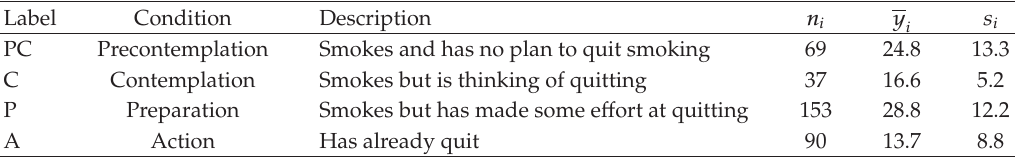
Table 4: Sample sizes, means, and sample standard deviations of 349 women who stopped smoking during pregnancy period (cid:5) 14 (cid:6)